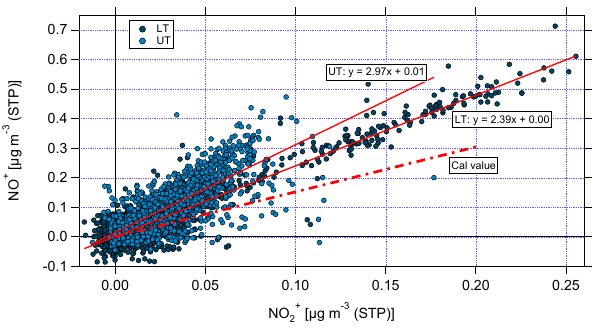
Figure 10. Scatter plot of NO + and NO + for the lower troposphere 2 (LT, dark blue) and the upper troposphere (UT, light blue). The ni- trate signals have been corrected for organic interference according to Fry et al. (2018). Linear fit curves are shown in red; the ratio of NO + and NO + derived from calibrations with ammonium nitrate is 2 presented by the red dashed